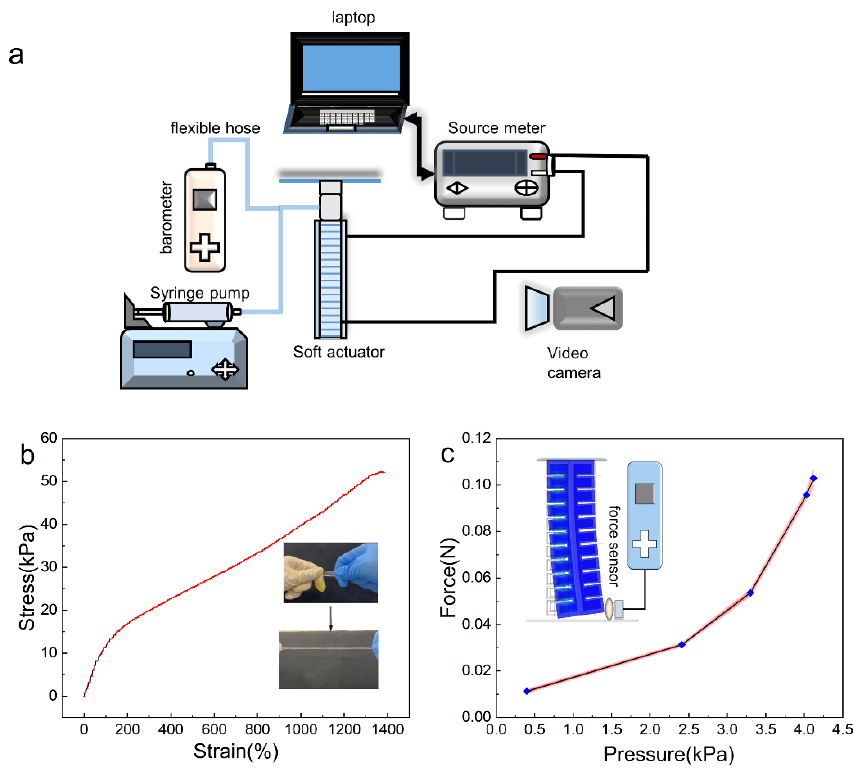
Figure 2. ( a ) The schematic diagram of the experimental setup. ( b ) The stress–strain curve of the hydrogel. ( c ) The generated force of the actuator at different pressures.